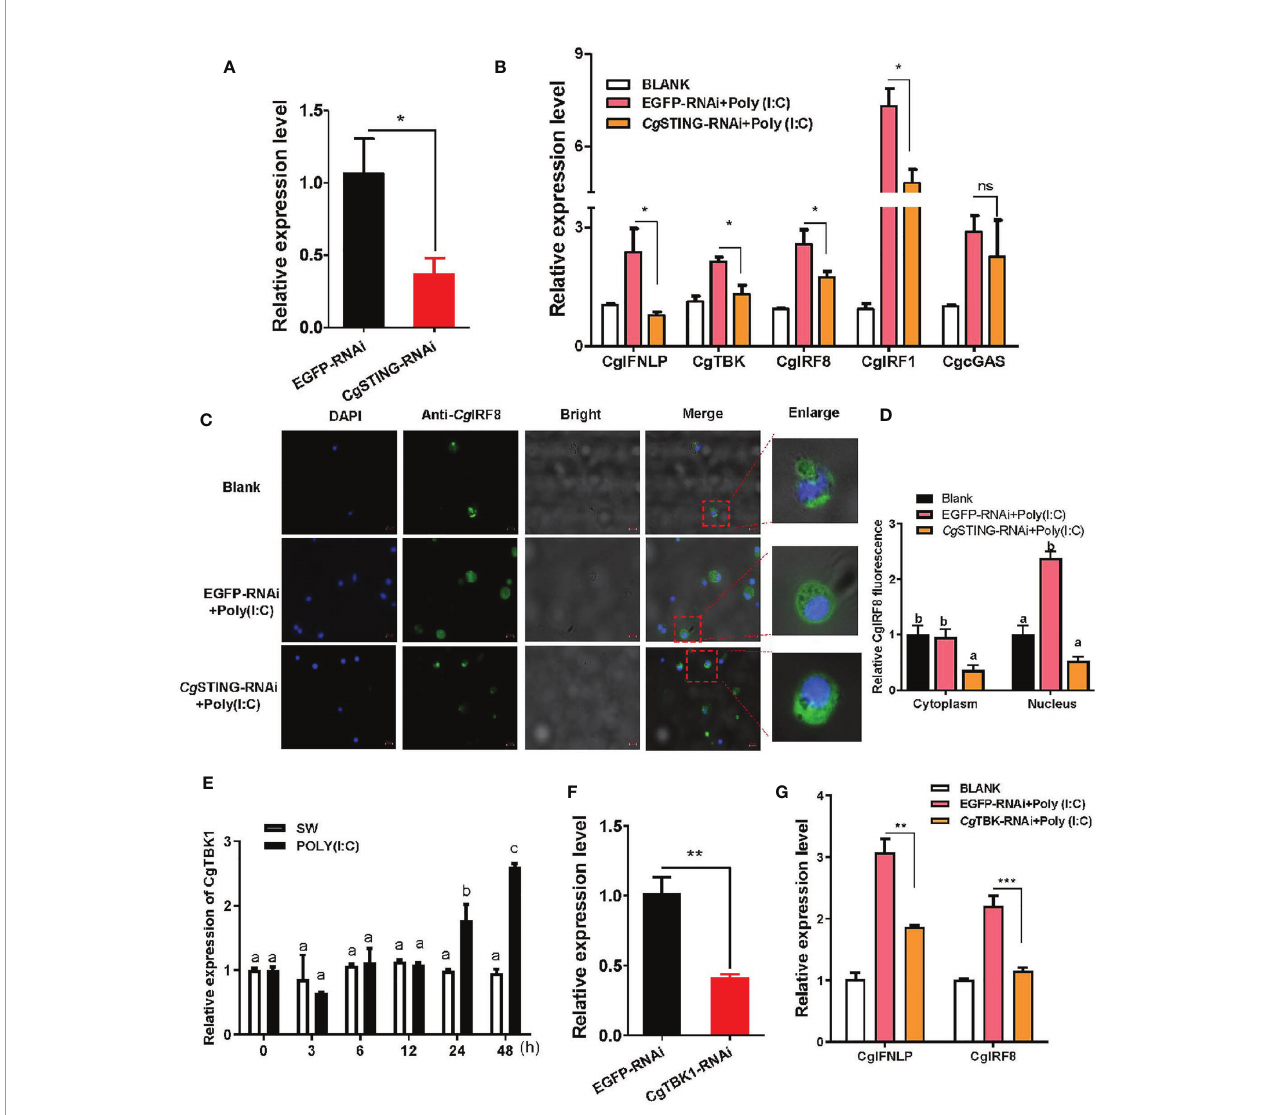
FIGURE 5 | The regulation of Cg STING and Cg TBK1 on the expression of Cg IFNLP and IRFs. (A) The ef fi ciency of Cg STING-RNAi in hemocytes (EGFP – RNAi was used as control). (B) The mRNA expressions of Cg IFNLP, Cg TBK1, Cg IRF-1, Cg IRF-8, and Cg cGAS in Cg STING – RNAi oysters after Poly (I:C) stimulation were detected by qRT-PCR. (C) The subcellular localization of Cg IRF-8 protein in hemocytes of Cg STING – RNAi oyster after Poly (I:C) stimulation. (D) The statistical analysis of relative fl uorescence intensity of Cg IRF-8 using ImageJ. Nucleus staining with DAPI was shown in blue signal; anti- Cg IRF-8 conjugated to Alexa- fl uor 488 was shown in green signal. (E) Temporal expression of Cg TBK1 mRNA after Poly (I:C) stimulation. (F) The ef fi ciency of Cg TBK1 – RNAi in hemocytes. (G) The mRNA expressions of Cg IFNLP and Cg IRF-8 in Cg TBK1 – RNAi oysters after Poly (I:C) stimulation. Vertical bars represent the mean ± SEM (N = 3). * p < 0.05; ** p < 0.01; *** p < 0.001; ns, not signi fi cant. The different letters show the existence signi fi cant di ff erences comparing with other groups ( p <